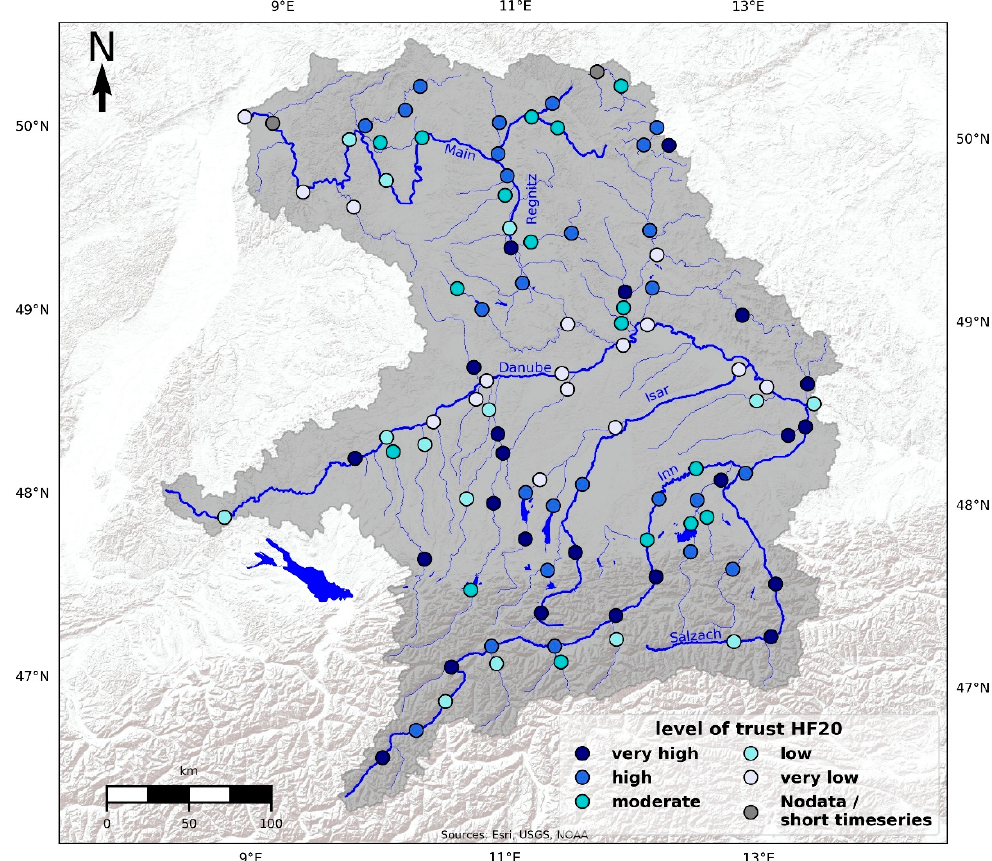
Figure 10. The level of trust (LOT) for high flows with a 20-year return period (HF20). Gray dots indicate gauges with no data or short timeseries. Qualitative categories: very high (LOT ≤ 10%), high (10% < LOT ≤ 20%), moderate (20% < LOT ≤ 30%), low (30% < LOT < 50%), and very low (LOT ≥ 50%).